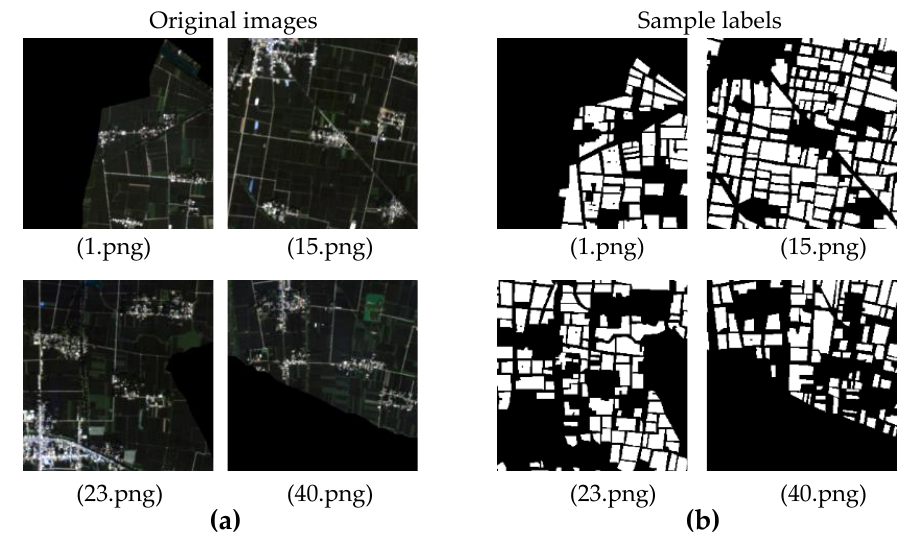
Figure 11. ( a ) Original sample images and ( b ) labeled samples.